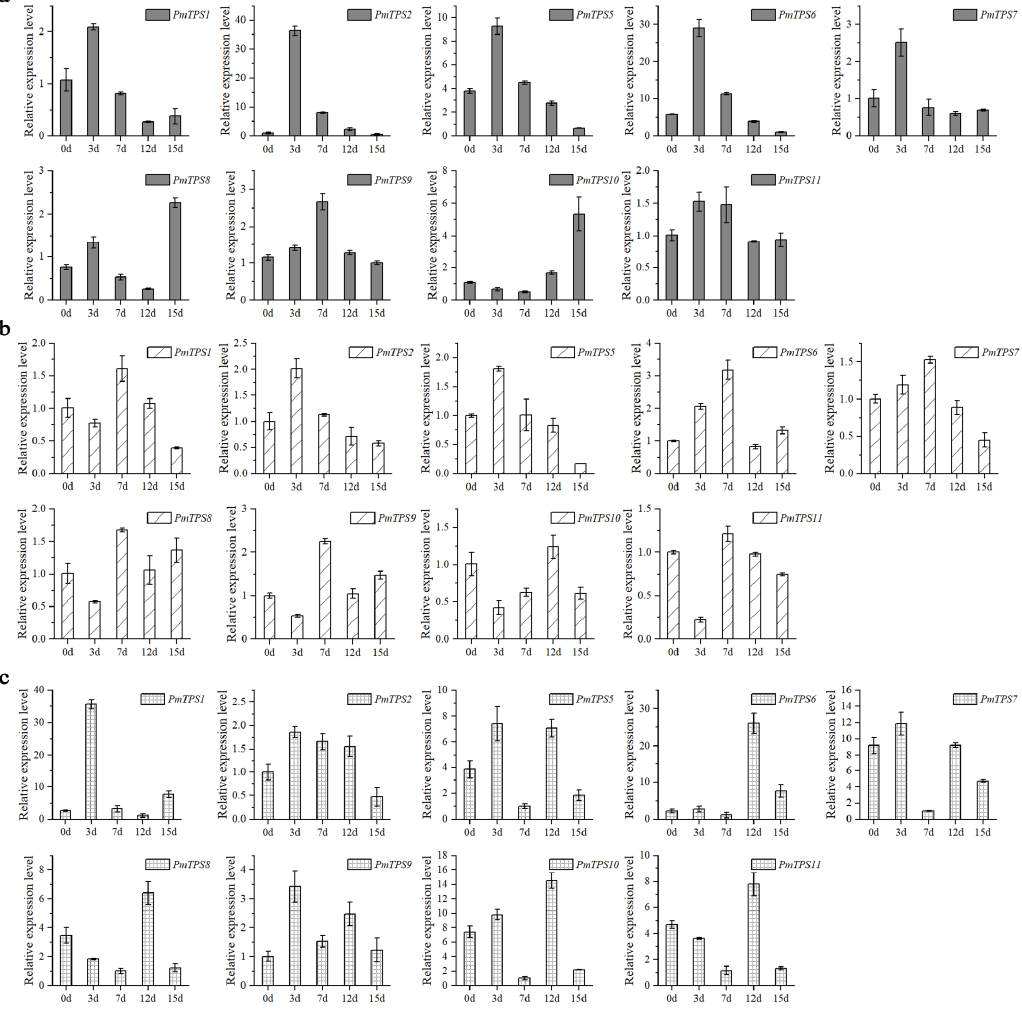
Figure 10. Expression patterns of TPS family genes in leaf ( a ), stem ( b ), and root ( c ) tissues of Prunus mume under drought stress by qRT-PCR. The abscissa axis represents water deficiency for 0d, 3d, 7d, 12d, and 15d. All qRT-PCR results are presented as mean value ± standard error from three biological replicates.